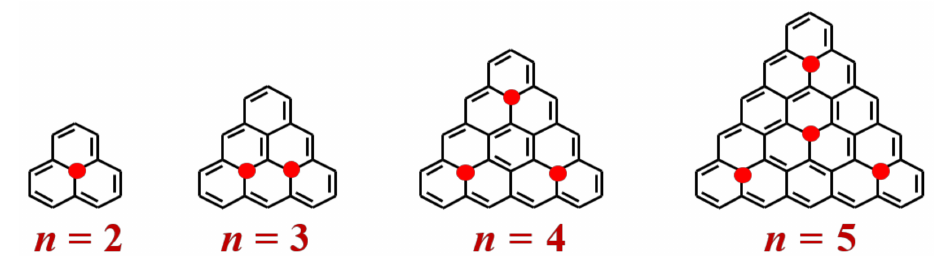
Figure 1. Structures of the first elements of n -triangulenes class; n is the number of benzene rings at one edge; the open spin sites are represented with red points, taking the resonance structures with the highest possible symmetry.